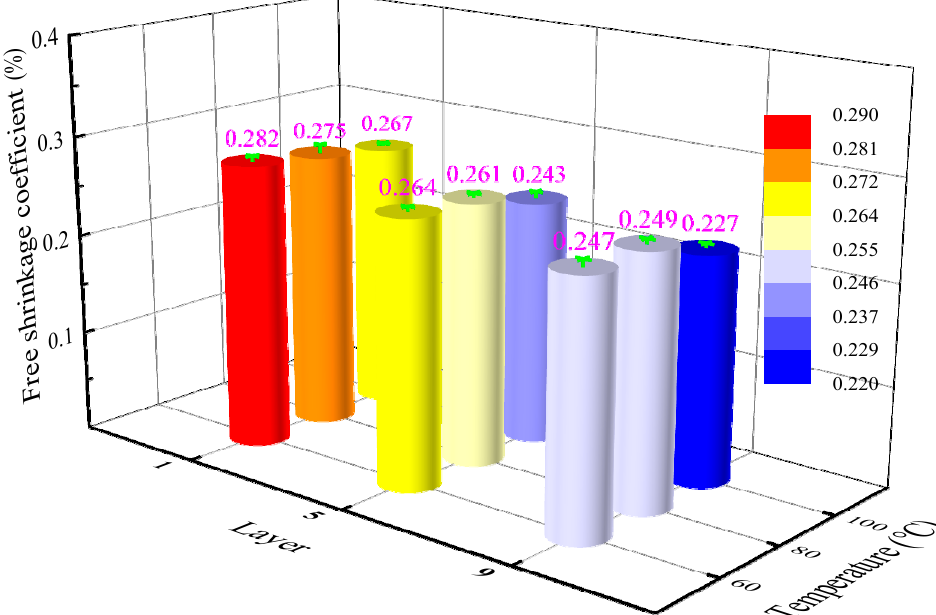
Figure 3. Effect of temperature on free shrinkage coefficient in the width direction of a representative layer on the thickness of the test material.